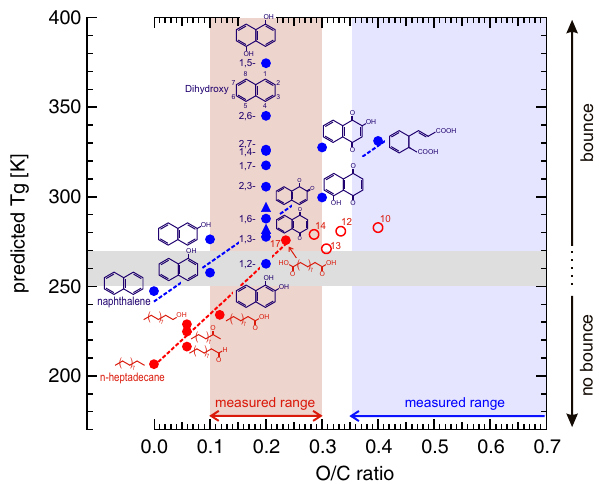
Fig. 8. Predicted glass transition temperatures T g as a function of the molecular O/C ratio for various oxygenated compounds originating from the parent structure of n -heptadecane (red) and naphthalene (blue). Open circles are predicted T g for n -dicarboxylic acids with the number of C-atoms indicates for each point. For details see